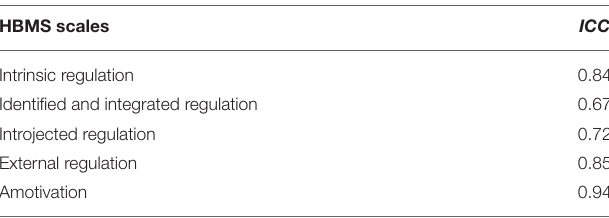
TABLE 9 | Results of the reliability assessments of the health behavior motivation scale (HBMS), Study